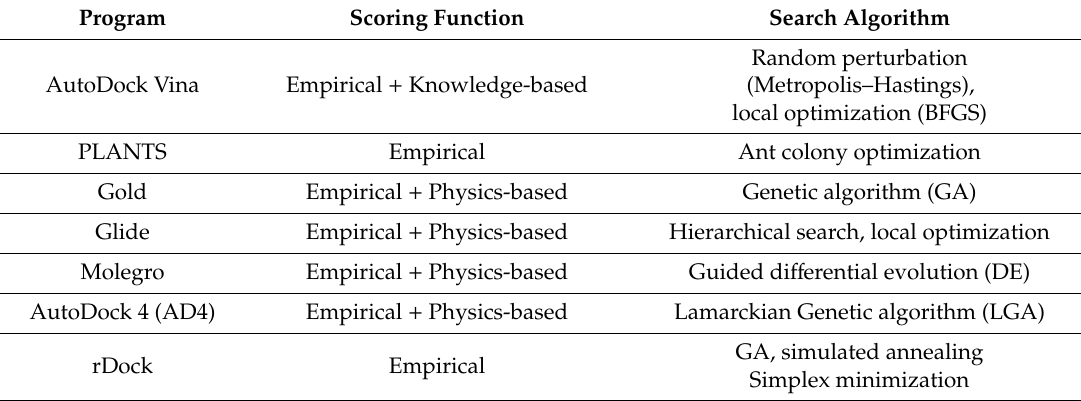
Figure 1. ( a ) Chemical transformations performed by CD38 involving important biomolecules such as NAD, ADPR, and cADPR. ( b ) Key interactions between CD38 and NAD (PDB code: 2O3U). Yellow, green, grey, and orange dotted lines represent salt-bridge, π – π , hydrophobic and π –cation interactions, respectively. A Van der Waals surface representation of the binding site ( c ), colored by the electrostatic potential, illustrates the shape and charge complementarity of the active site. Table 1. Overview of the scoring functions and search algorithms of the programs